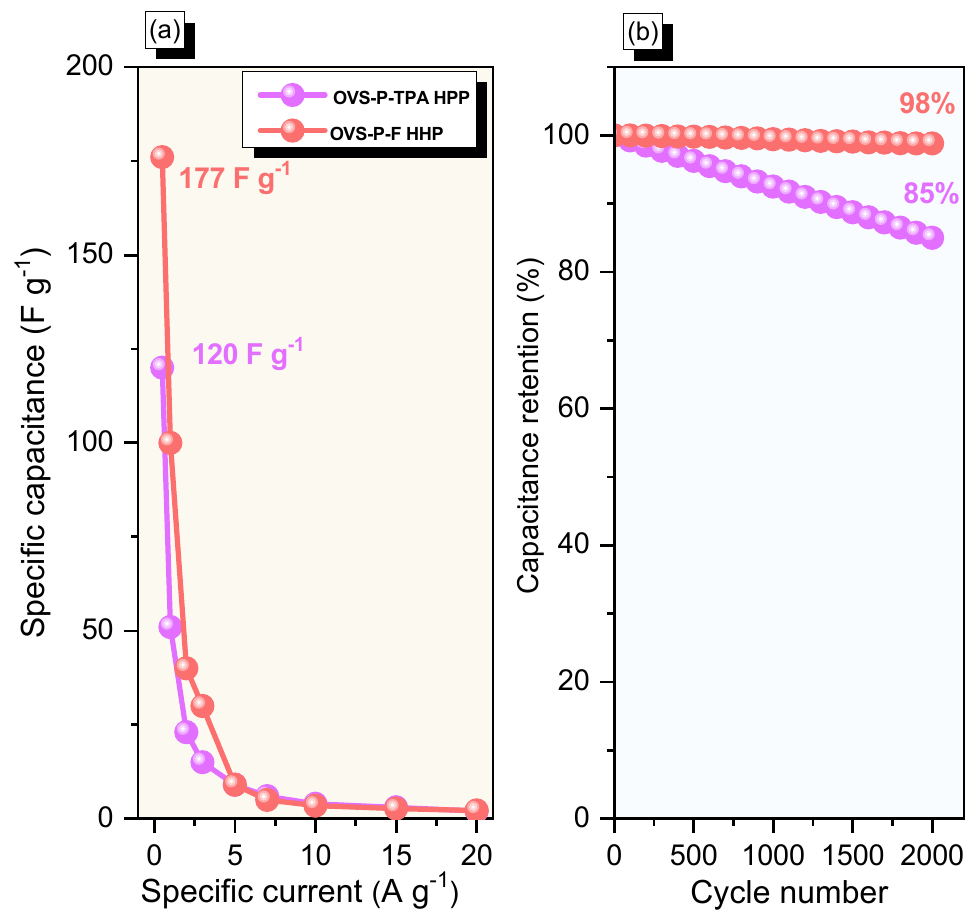
Figure 8. ( a ) Specific capacitance and ( b ) stability profiles for OVS-A HPP and OVS-P-A HPP. In addition, we examined the electrochemical properties of the OVS-A HPP and OVS-P-A HPP for a symmetric supercapacitor using coin cells (Figure S4). The CV profiles of OVS-A HPP and OVS-P-A HPP were measured at the same scan rates and potential windows as the three electrodes (Figure S4a,b). The CV curve for OVS-A HPP (Figure S4a) is quite similar to the three-electrode system, but in OVS-P-A HPP (Figure S4b), the humps appeared more prominently to assist in the presence of both EDLC and pseudocapacitance. The pure triangular GCD curve was observed for OVS-A HPP, suggesting the presence of EDLC (Figure S4c), and OVS-P-A HPP experienced a triangular curve with some